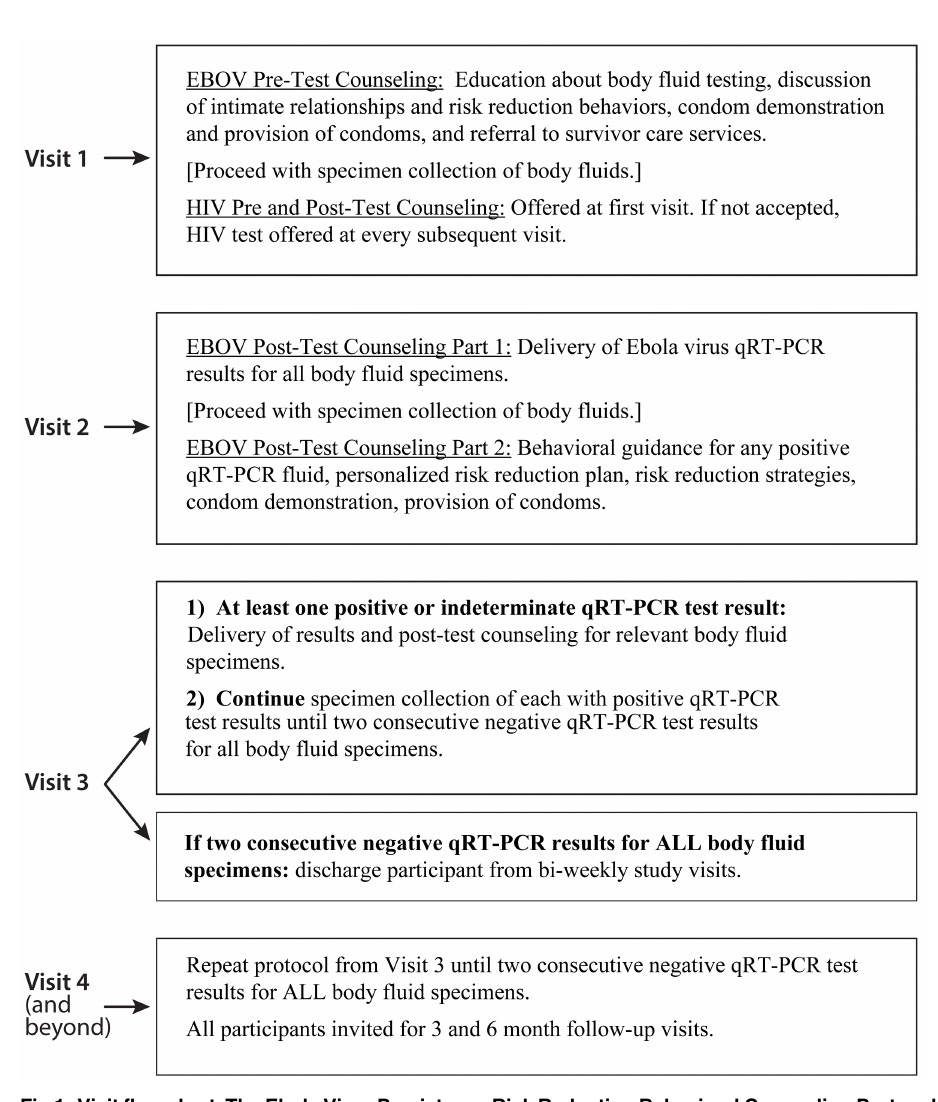
Fig 1. Visit flow chart. The Ebola Virus Persistence Risk Reduction Behavioral Counseling Protocol visit flow chart. (A) Visit 1 Description of EBOV pre-test counseling, and HIV pre and post-test counseling procedures. (B)Visit 2 Description of EBOV post-test counseling part 1 and 2 procedures. (C) Visit 3 Description of proceduresif at least one positive, indeterminate, or no interpretation qRT-PCR test results was found, or if all body fluid specimenswere found qRT-PCR negative. (D) Visit 4 and Beyond: Descriptionof repeat visits until two consecutive negativeqRT-PCR test results for all body fluid specimens.